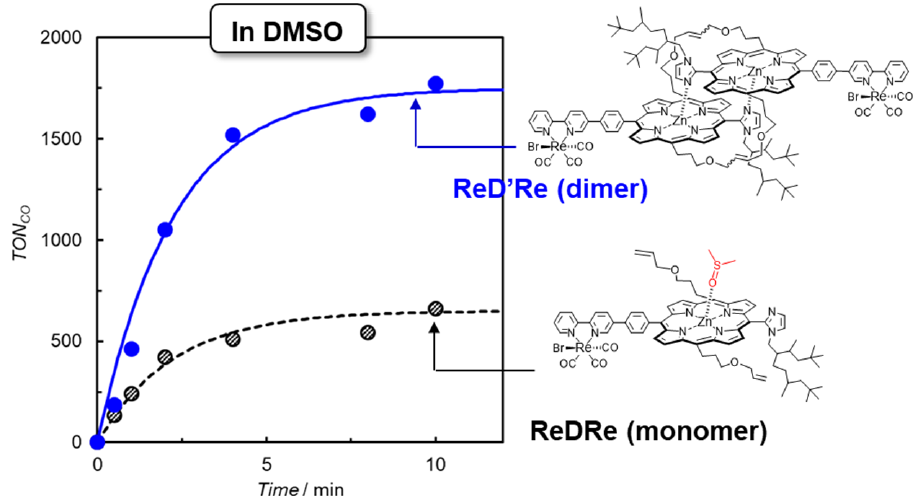
Figure 15. CO formation with time during irradiation at 560 nm from LED lamps for CO 2 -saturated DMSO–TEOA solutions containing ReD ′ Re (2.5 μ M) and ReDRe (2.5 μ M) in the presence of BIH (0.01 M, 2000 equiv against the Re complex). The TON CO is calculated against the Re